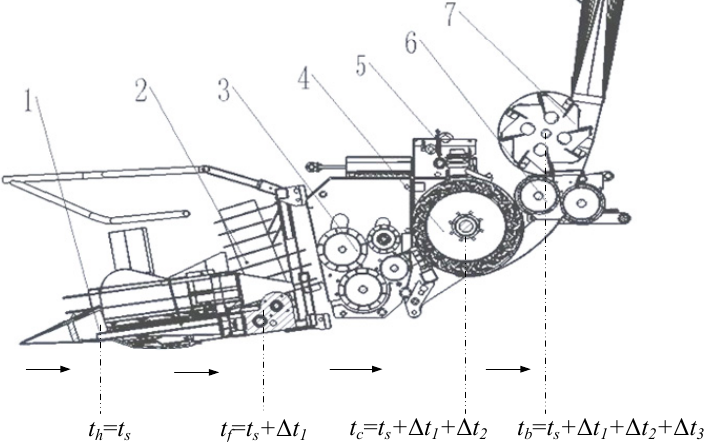
Figure 4. Time lag analysis of silage flow in the harvester. 1: header; 2: conveying roller; 3: feeding rollers; 4: shedding rollers; 5: self-sharpening unit; 6: self-sharpening unit; 7: kernel-processing unit.